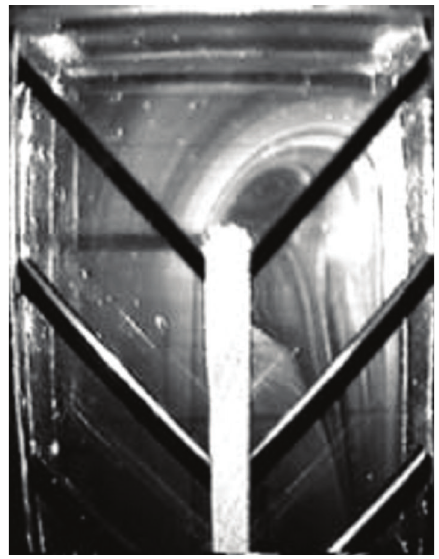
Figure 24: Flow visualization image from Elfert et al. [50] for the 180 ∘ bend region of the two-pass channel, viewing the flow in the positive y -direction with the bend entrance on the left and the bend exit on the